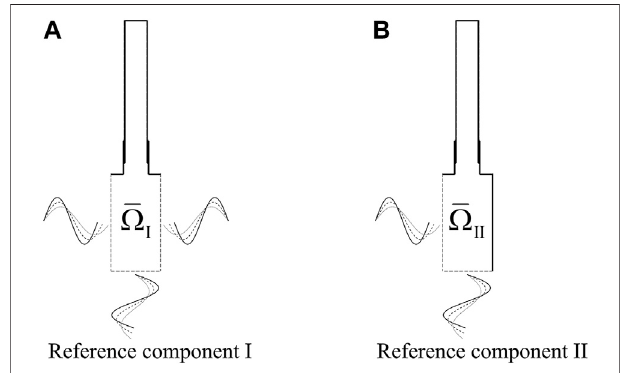
FIGURE 2 | Schematic of the component-based ROM training method based on (A) reference components I and (B) II.